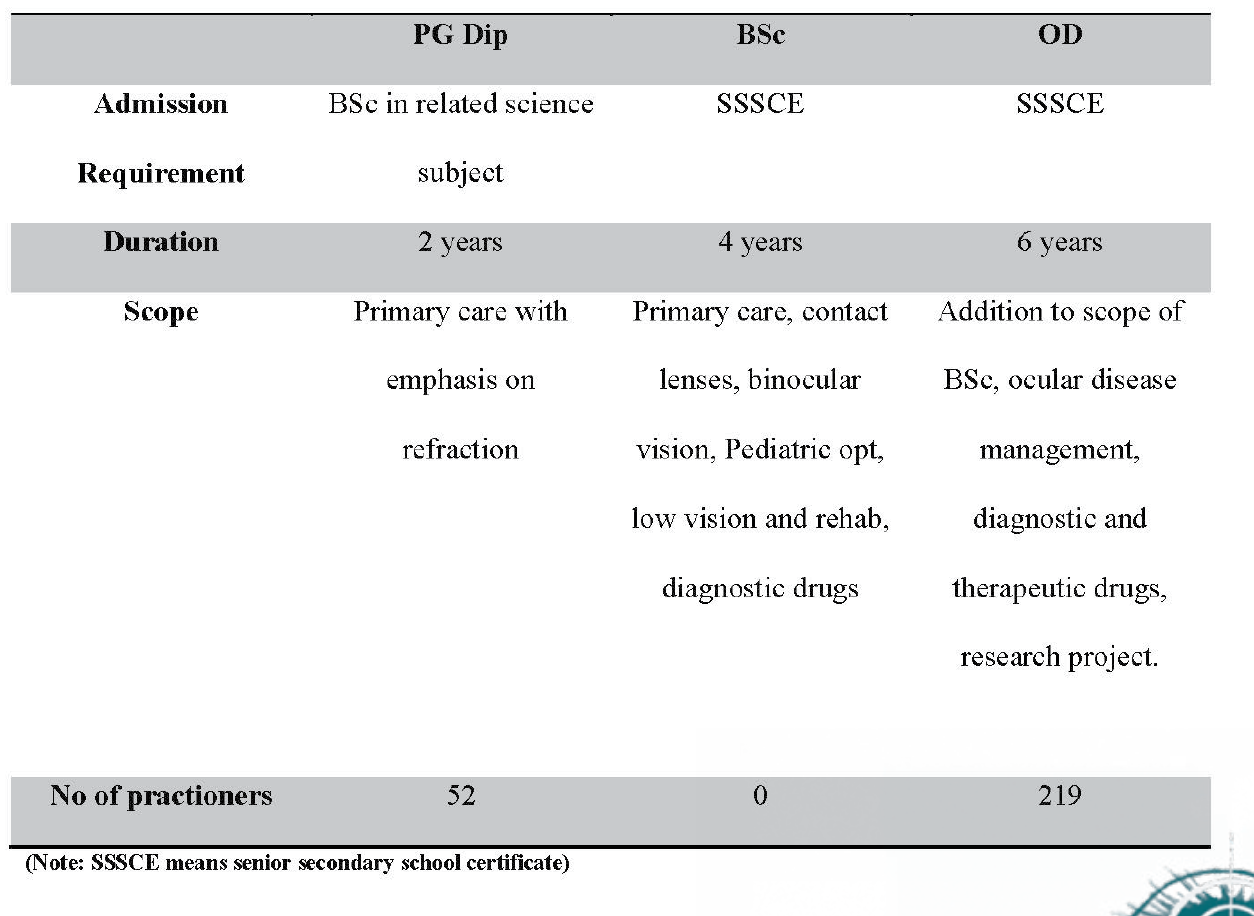
Table 1: Comparison of the phases of optometric education in